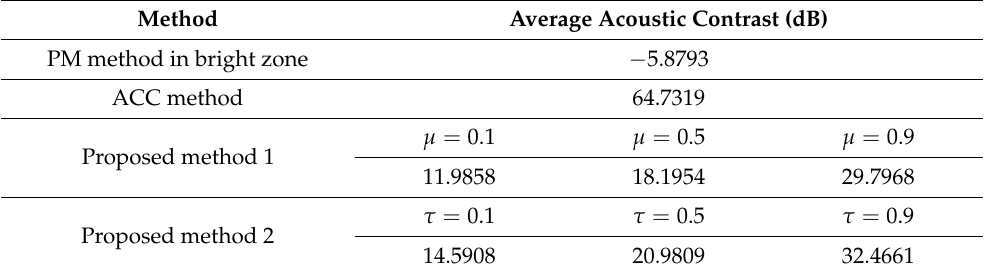
Table 12. Average acoustic contrast of different methods relative to frequency for three-dimensional experiment with sparse sampling points.